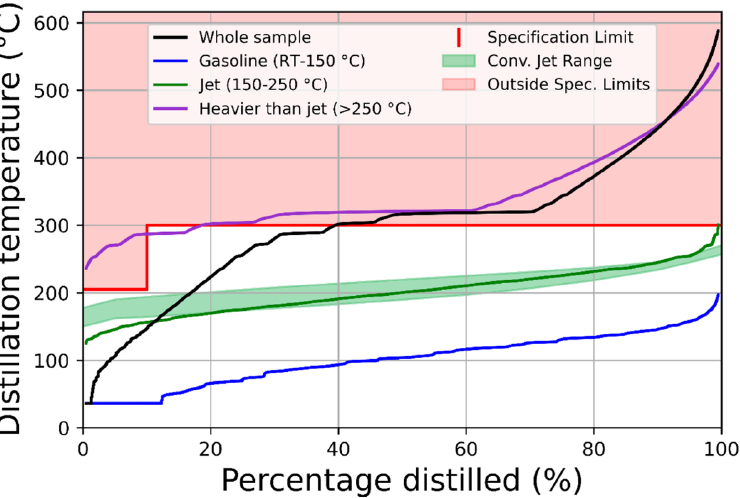
Figure 5. Simulated distillation data for a whole upgraded WWHTLB sample (CoMo:S1), as well as those of the gasoline, JFC, and HTJC fractions obtained via fractional distillation, with comparison to the collective analysis of 3 aviation fuels (POSF 10325, 10264, and 10289) [54].